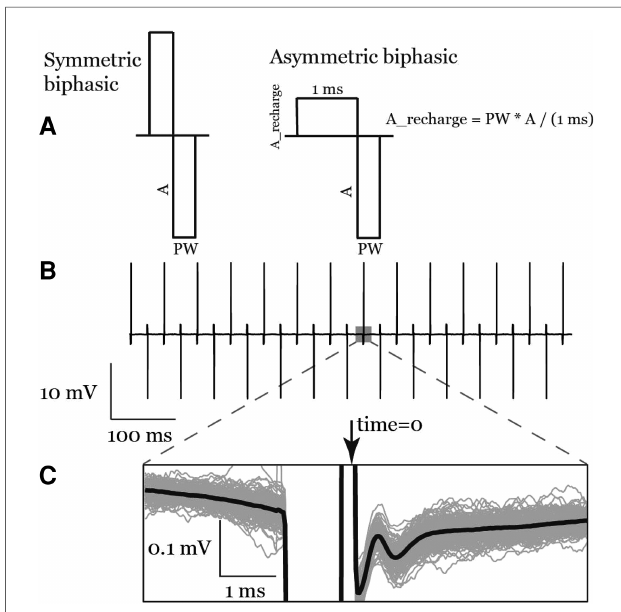
FIGURE 3 ( A ) the symmetric biphasic and asymmetric biphasic (used in this study) stimulation waveforms. ( B ) A raw recording of a train of asymmetric biphasic interleaved pulses. ( C ) Inset shows anodic pulse ECAPs signal in the average waveform (bold line) as well as the individual traces (gray